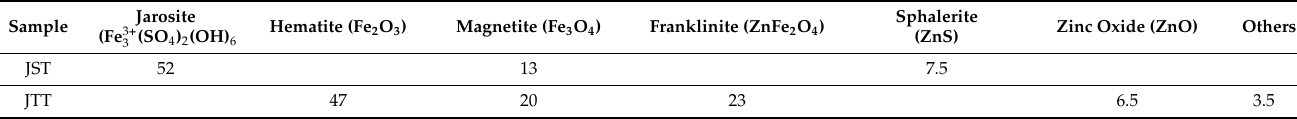
Table 2. Iron phases distribution (%) in